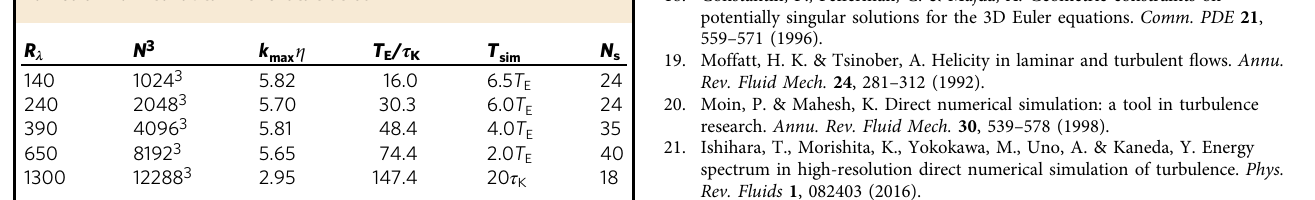
Table 1 Simulation parameters for the DNS runs used in the current work: the Taylor-scale Reynolds number ( R λ ), the η ), ratio number of grid points ( N 3 ), spatial resolution ( k max of large-eddy turnover time ( T E ) to Kolmogorov time scale ) in statistically stationary ( τ K ), length of simulation ( T sim state, and the number of instantaneous snapshots ( N s ) used for each run to obtain the